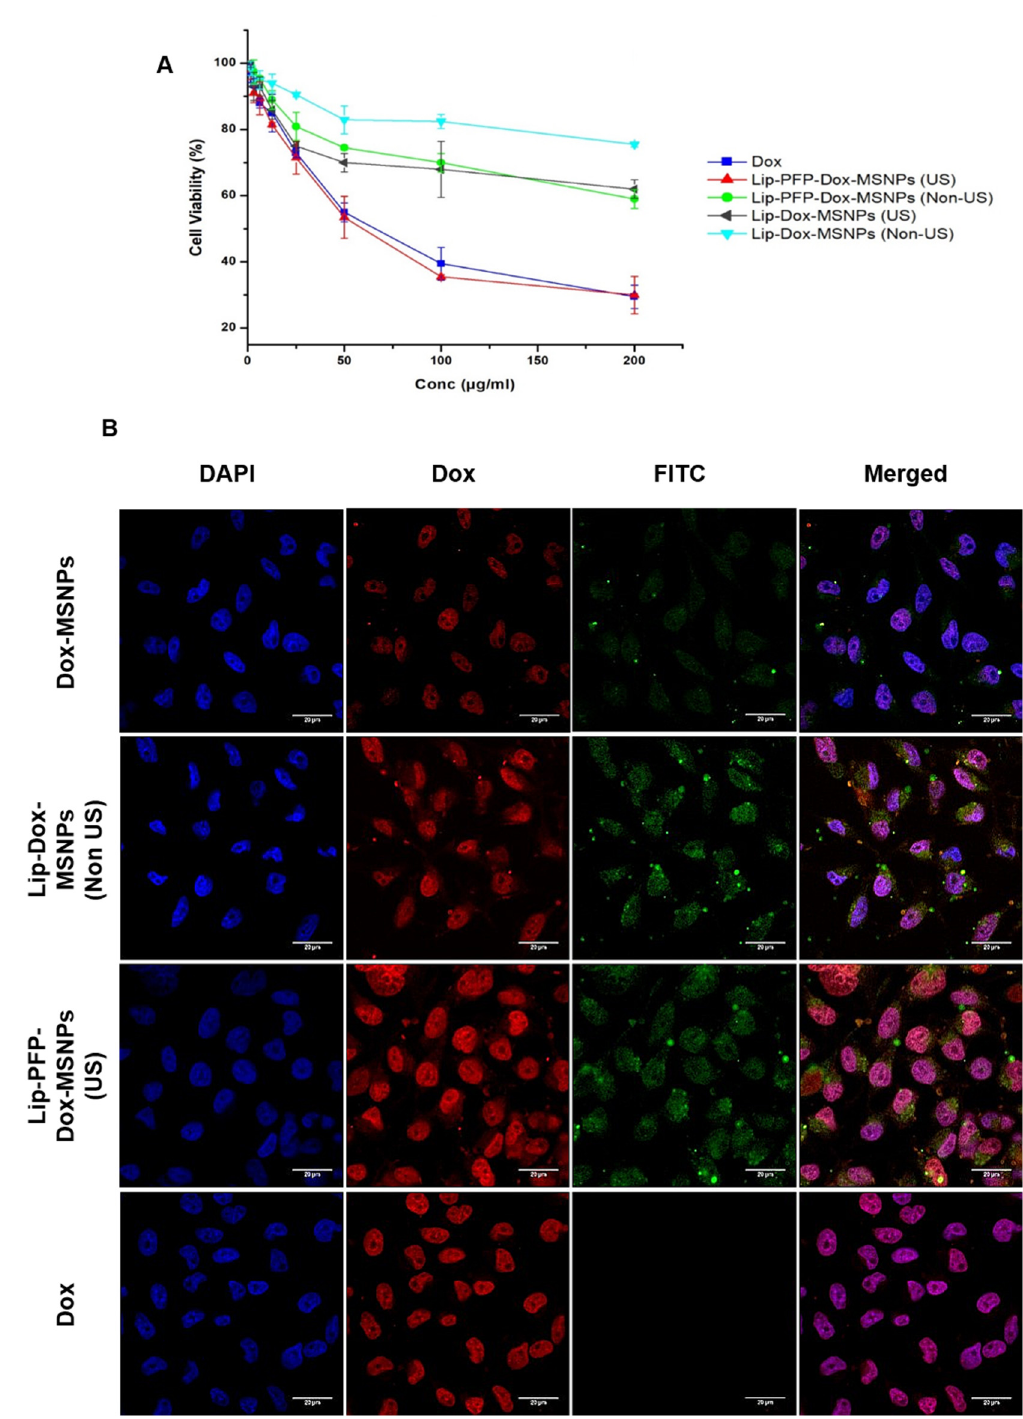
Figure 8. ( A ) In vitro cytotoxic effects of Dox loaded carriers to MDA-MB-231 cells. A comparative cytotoxicity of Lip-Dox-MSNPs and Lip-PFP-Dox-MSNPs with US (5 min, 12 MHz, MI 1.4) and Non-US, where Lip-PFP-Dox-MSNPs (US) showed more cytotoxic effects compared to other groups. ( B ) Cellular uptake studies with confocal microscopy with FITC (green) labelled nanocarriers. Dox-MSNPs, Lip-Dox-MSNPs (Non-US), and Lip-PFP-Dox-MSNPs (US), showing localization of Dox (red) in the nuclei, stained with DAPI (blue), and a scale bar of 20 µm. Higher internalization of Dox with Lip-Dox-MSNPs showed higher cellular uptake due to lipid coating and even higher in Lip-PFP-Dox-MSNPs due to triggered release by US-irradiation, scale bar = 20 µm.